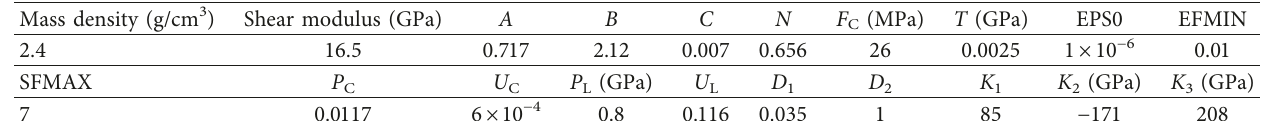
Table 2: Material model parameters of concrete.